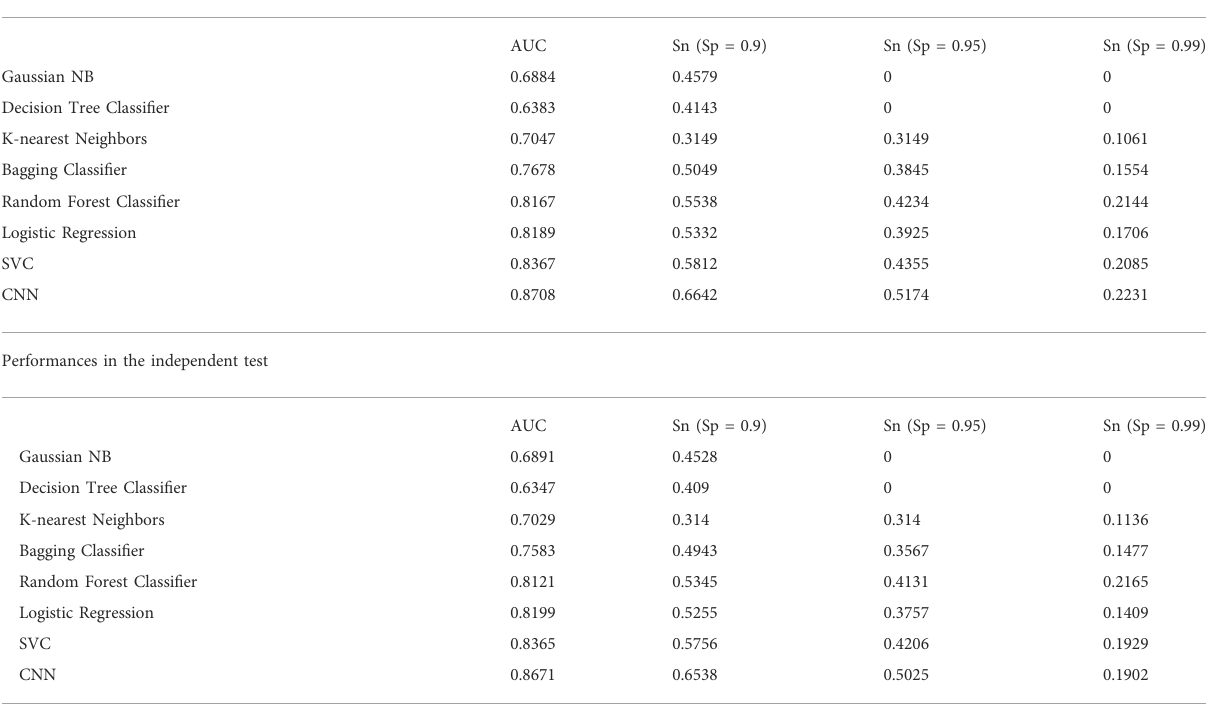
TABLE 1 Prediction Performances of different models integrating the One-Hot encoding approach. Performances in ten-fold